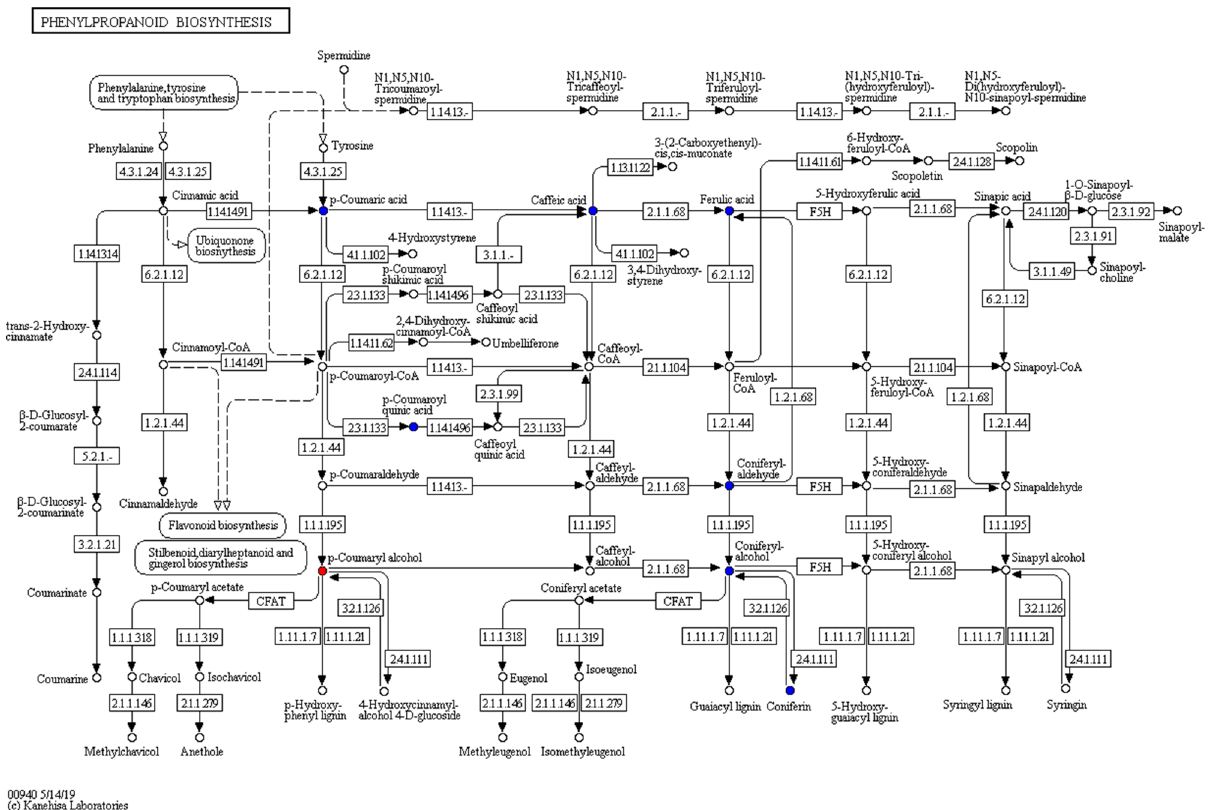
Figure 5. Phenylpropanoid biosynthesis. The red dots: the differentially expressed metabolites that are increased, the blue dots: the detected metabolites, but there is no significant